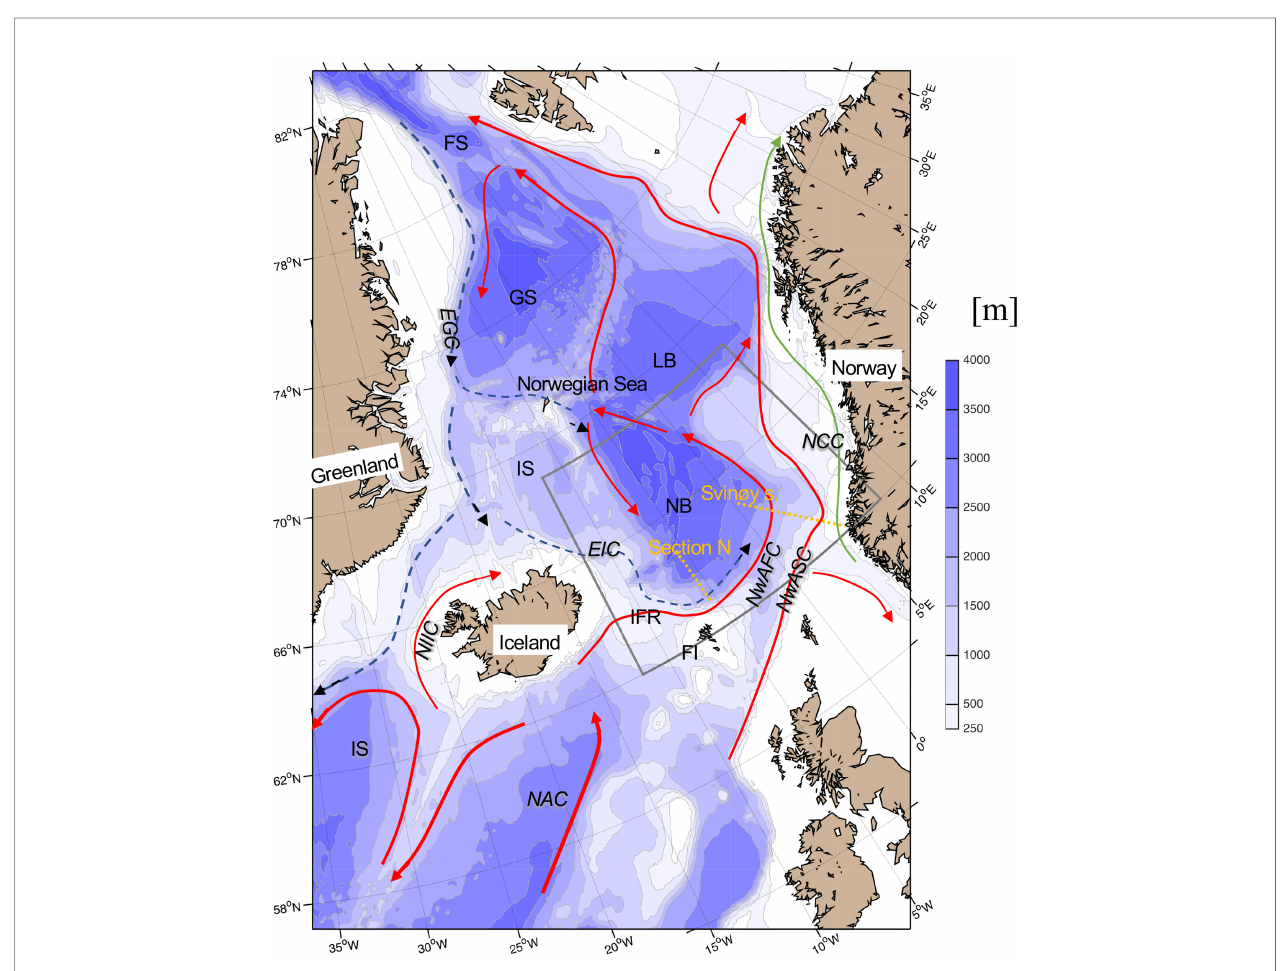
FIGURE 1 | Map of the investigation area including schematic of the major currents associated with Atlantic Water in red, Arctic and Polar Water in black dashed, and freshwater boundary current in green. Yellow dashed lines show position of the repeated section used in this study; the Section N and the Svinøy section. The square shows the area used to calculate integrated quantities for the Norwegian Basin. North Atlantic Current, (NAC); Irminger Sea, (IS); North Icelandic Irminger Current, (NIIC); East Icelandic Current, (EIC); Iceland-Faroe Ridge, (IFR); Faroe Islands, (FI); Norwegian Atlantic Slope Current, (NwASC); Norwegian Atlantic Front Current, (NwAFC); Norwegian Coastal Current, (NCC); East Greenland Current, (EGC); Norwegian Basin, (NB); Lofoten Basin, (LB); Iceland Sea, (IS); Greenland Sea, (GS) and Fram Strait, (FS). Color show water depth in